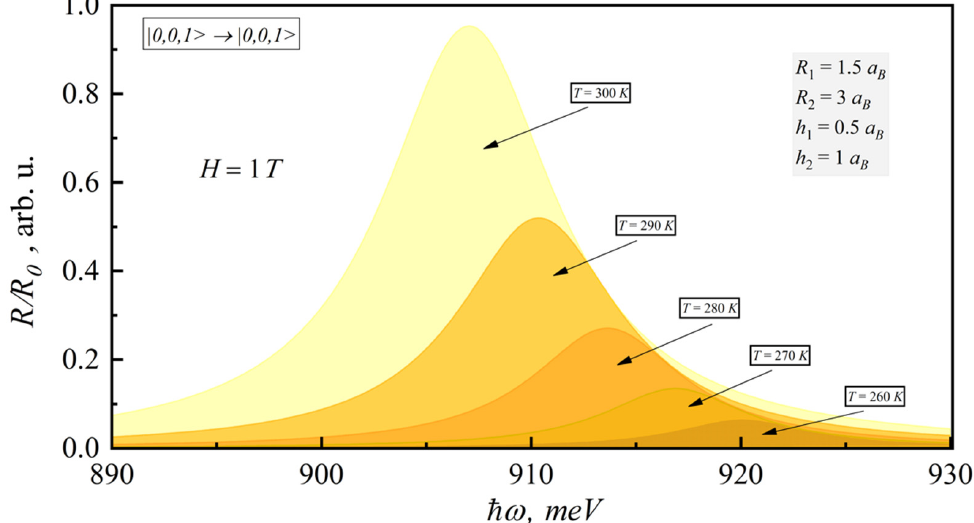
Figure 6. Dependence of the room-temperature PL coefficient on photon energy for different tem- peratures.